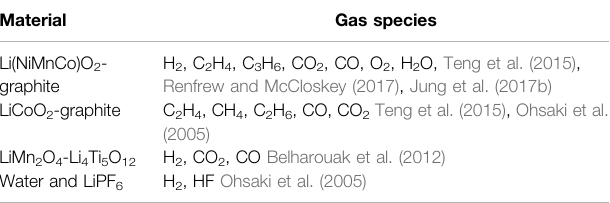
TABLE 1 | Gas species summarized from literature. Material Gas